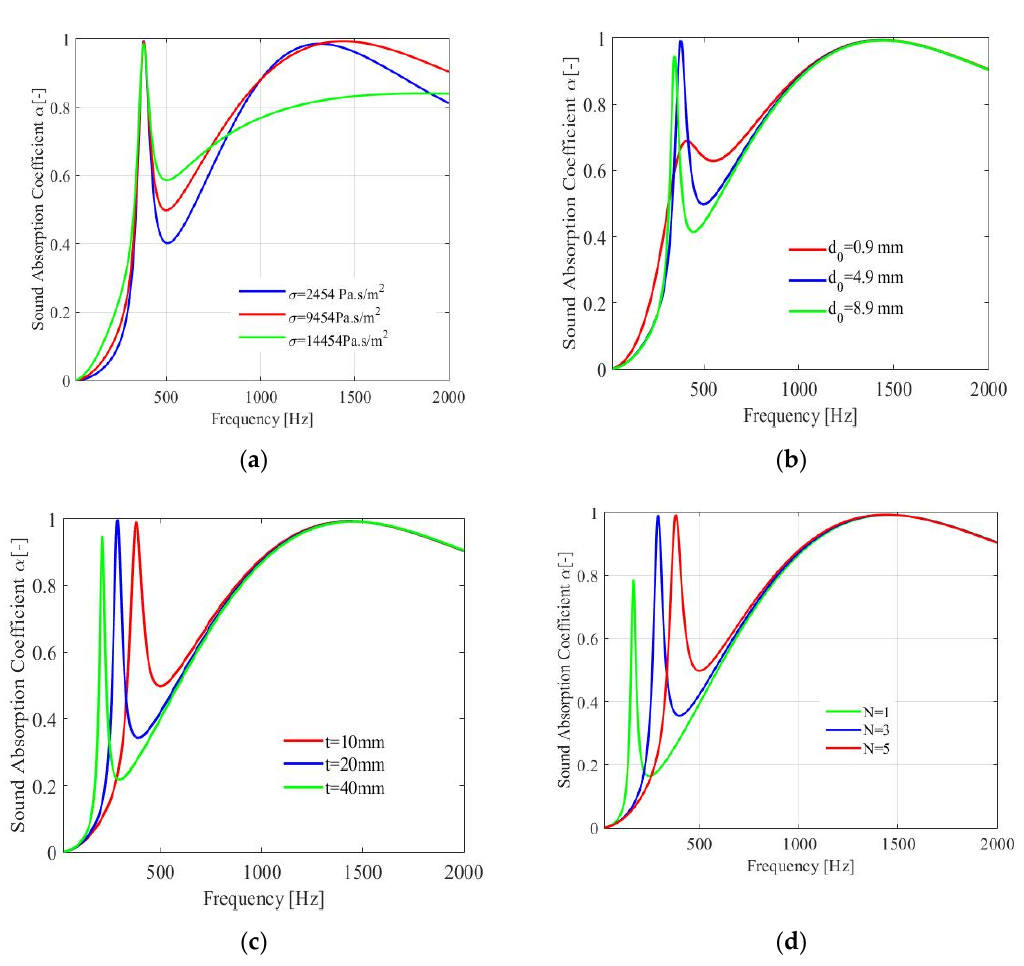
Figure 3. Comparison of the normal incidence sound absorption of composite absorber with different parameters. ( a ) The resistivity of melamine foam; ( b ) The diameter of extended tubes; ( c ) The length of extended tubes; ( d ) The number of extended tubes.